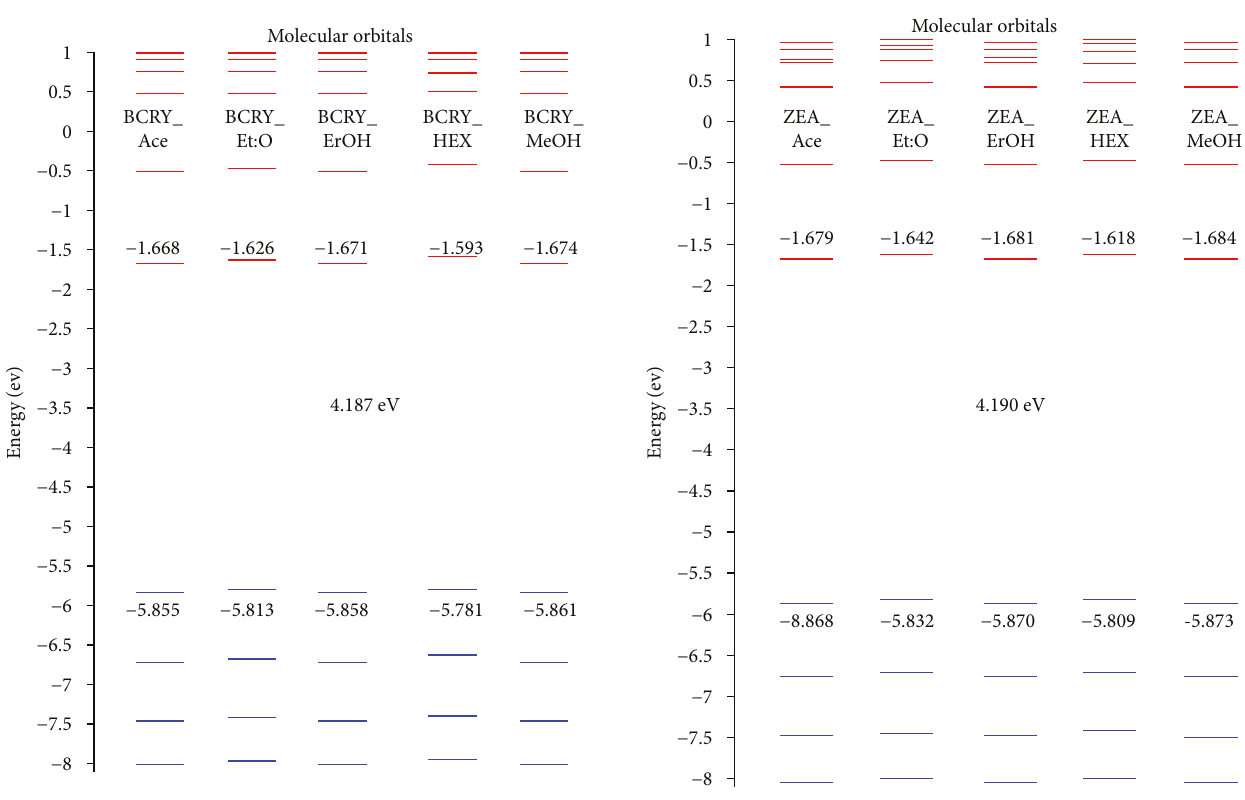
lations. Table 1: CHLA Cartesian coordinates. Table 2: CHLB Cartesian coordinates. Table 3: BCRY Cartesian coordinates. Table 4: ZEA Cartesian coordinates. Table 5: LUT Cartesian coordinates. Table 6: VIO Cartesian coordinates. Table 7: 9NEO Cartesian coordinates. Table 8: NEO Cartesian coor-